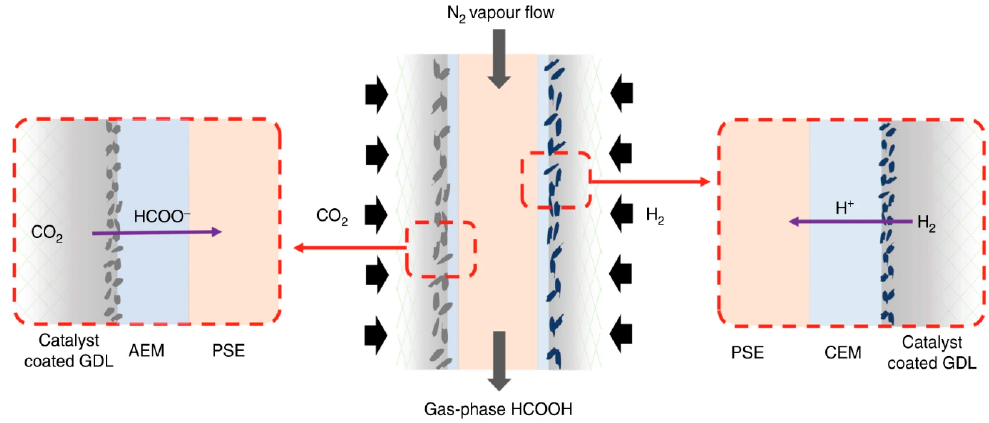
Figure 5. Schematic illustration of the all-solid-state electrochemical CO 2 to formic acid reactor: EM = anion exchange membrane, CEM = cation exchange membrane, GDL = gas diffusion layer, PSE = porous solid electrolyte. Electrochemically generated HCOO − and H + ions are driven by the electric field to move across the EM or CEM into the PSE layer, where they recombine to form the formic acid molecule. This can then be released quickly in the vapor phase via the N 2 carrier gas flow. Reproduced with permission from ref. [29] Copyright 2020, Springer Nature.